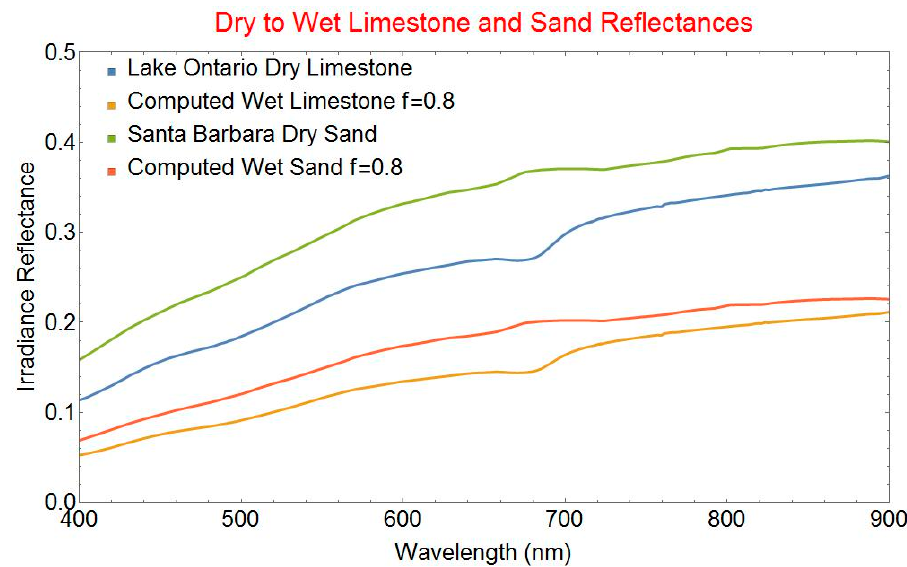
Figure 9. Computed irradiance reflectance for wet limestone and beach sand. The spectral signature for dry limestone comes from the shore of Lake Ontario. The signature of dry sand comes from a beach in Santa Barbara.